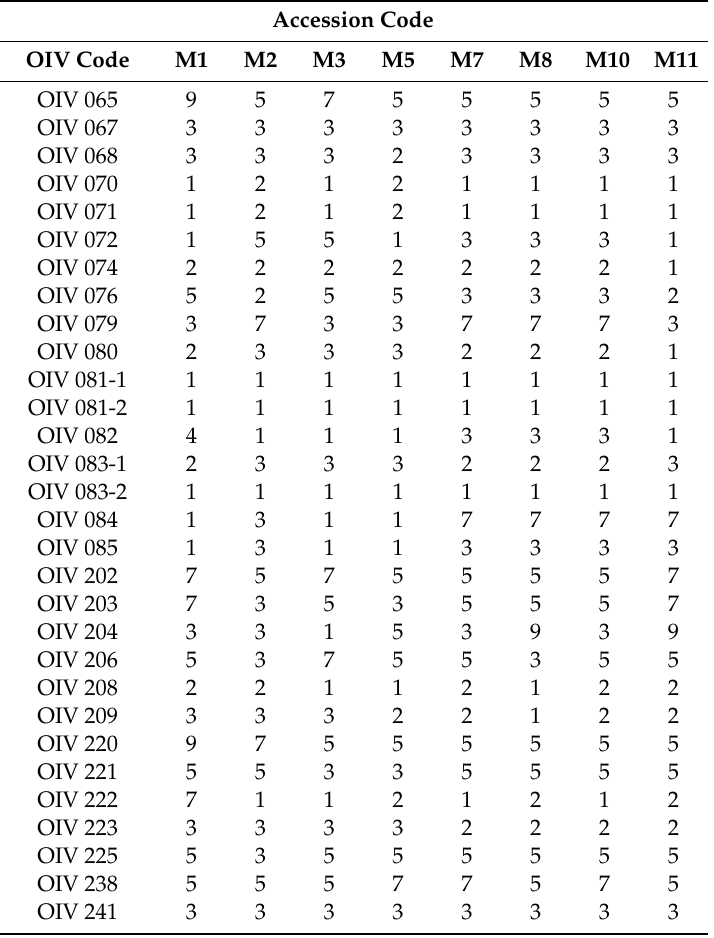
Table 3. Ampelographic characteristics of 30 OIV descriptors on grapevine accessions located in Axarquia (Malaga, Spain).